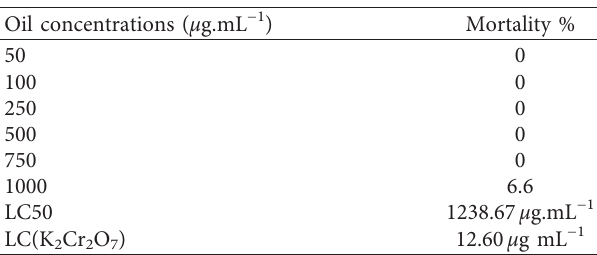
Table 3: Percent mortality of A. salina larvae of T. procumbens oil at different concentrations.